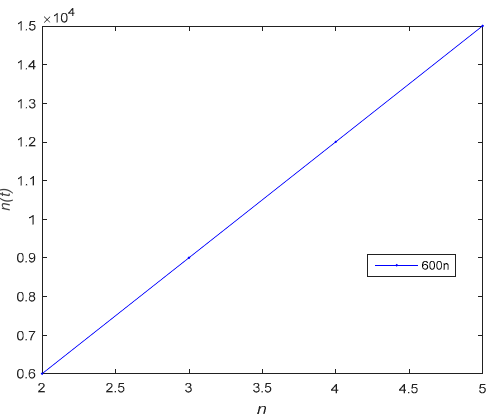
Figure 7. Risk level with a large number of attackers under feedback control.